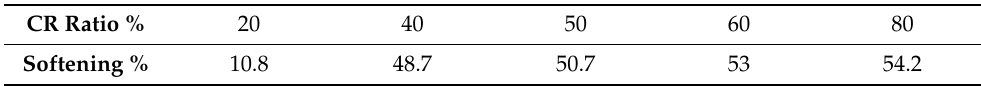
Table 4. Softening percentage of EUROFER97 steel, in the temperature range of the annealing heat treatment from 400 ◦ C to 750 ◦